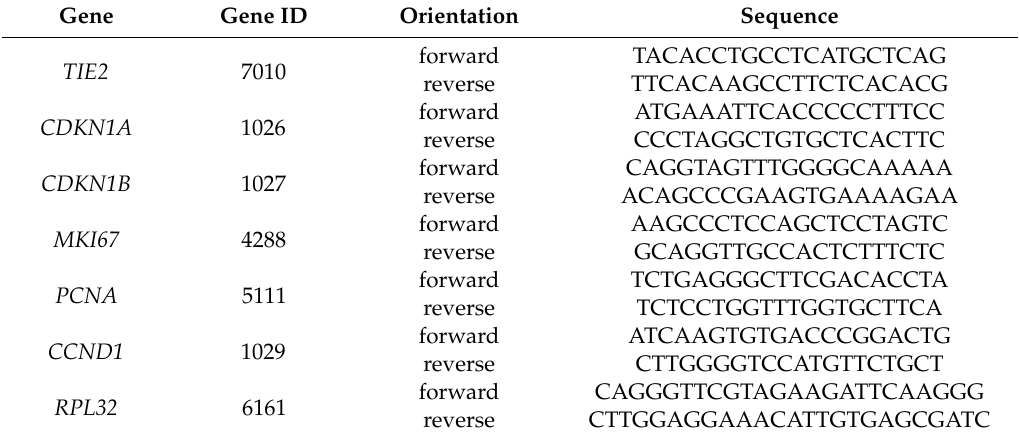
Table 1. Sequences of oligonucleotides used for real-time